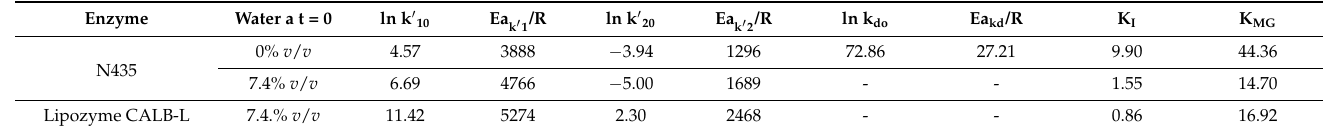
Table 10. Comparison of kinetic models and parameters for triphasic systems using toluene as cosolvent in the liquid apolar phase ([35], this